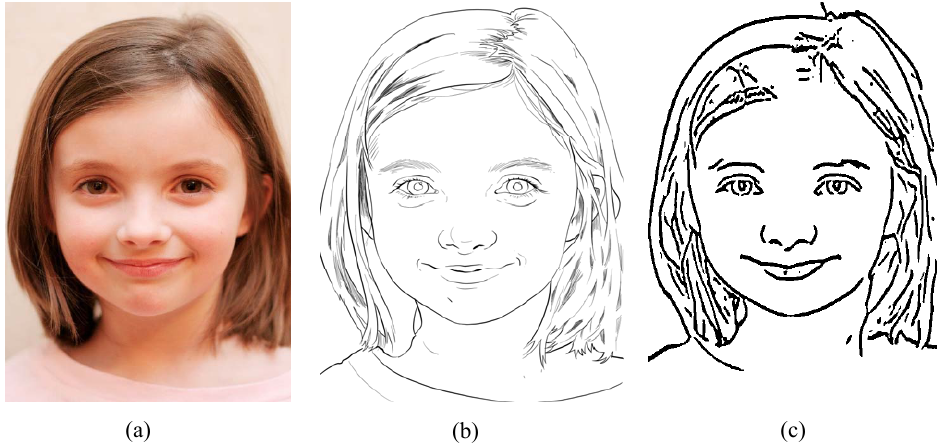
Figure 1. Comparison of the produced results with artistic line-based sketch: ( a ) input hedcut portrait image, ( b ) a line-based sketch artwork created by a professional artist, ( c ) the produced